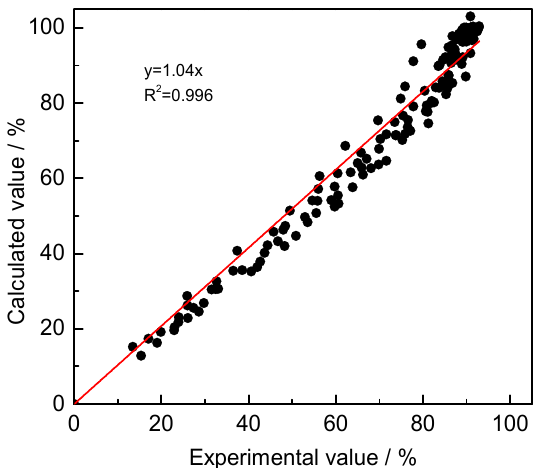
Figure 11. Comparison between the calculated Ti leaching rate using Equation (30) and all the experimental results in this work.